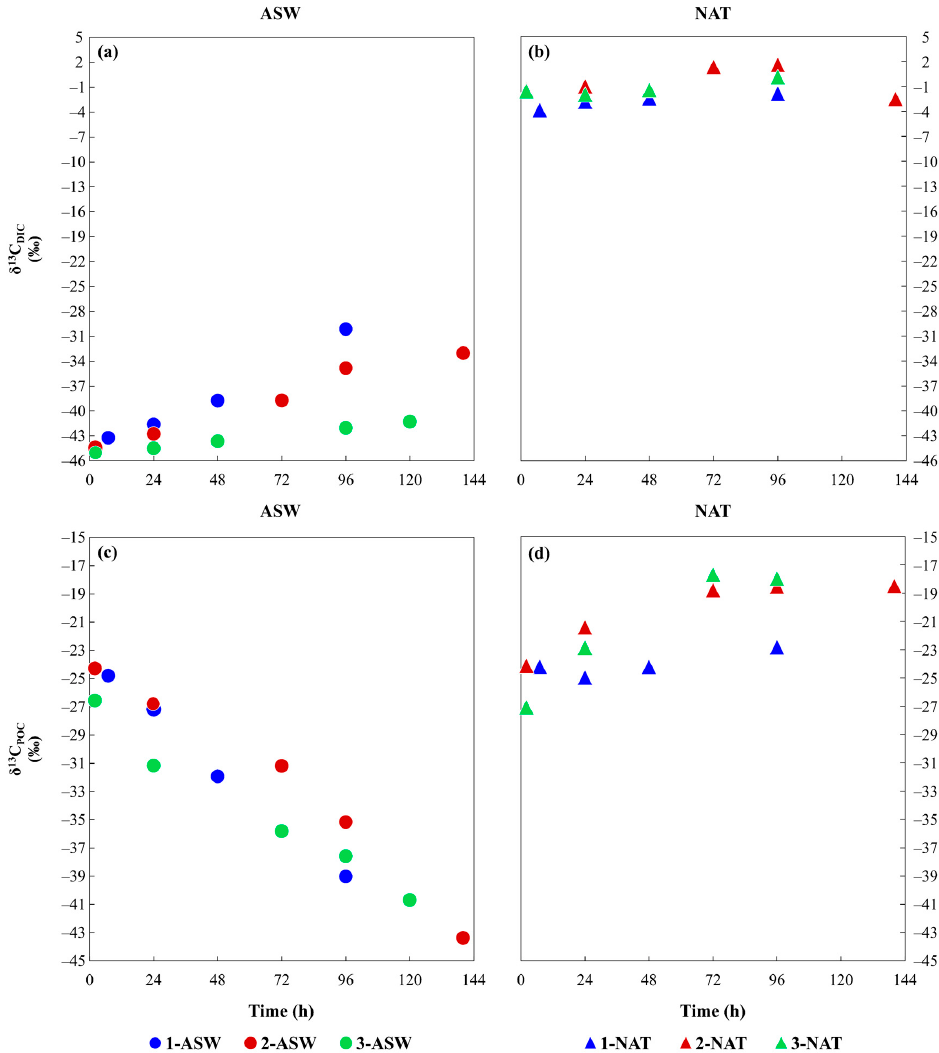
Figure 4. Time variation of the isotopic composition of ( a , b ) dissolved inorganic carbon ( δ 13 C DIC ), and ( c , d ) phytoplankton ( δ 13 C POC ) in the three T. rotula culture experiments. Circles represent the artificial seawater medium (ASW) and triangles the natural seawater medium (NAT). Blue symbols represent the first experiment (EXP-1), red the second experiment (EXP-2) and green the third experiment (EXP- 3).